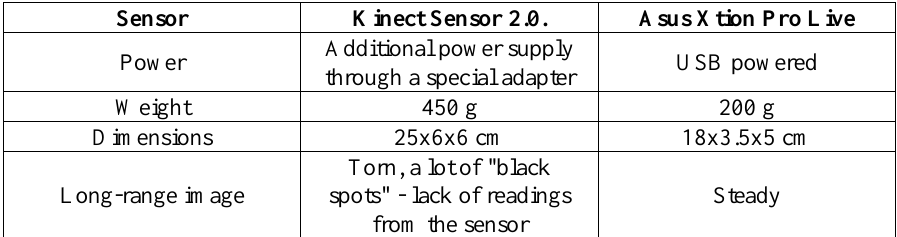
Table 1. Comparative characteristics of Kinect Sensor 2.0. and Asus Xtion Pro Live.